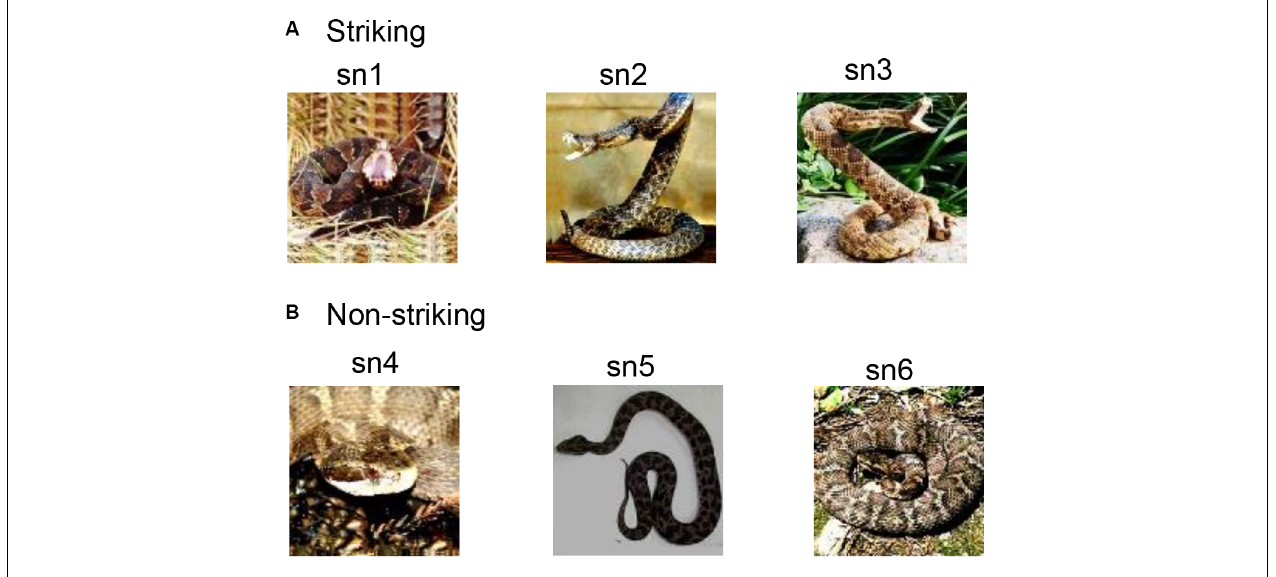
FIGURE 1 | Visual stimuli used in a neurophysiological recording from the monkey medial prefrontal cortex (mPFC). (A) Three photos of snakes with striking postures. (B) Three photos of snakes with non-striking postures. The same visual stimuli used in the study by Le et al. (2014) were also used in the present study.